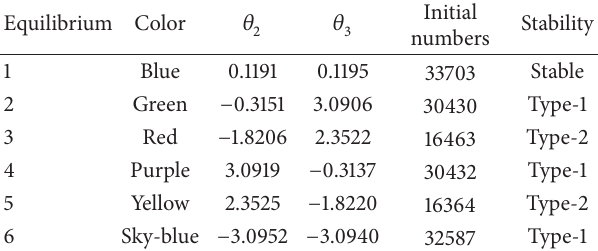
Table 1: Multiple power flow